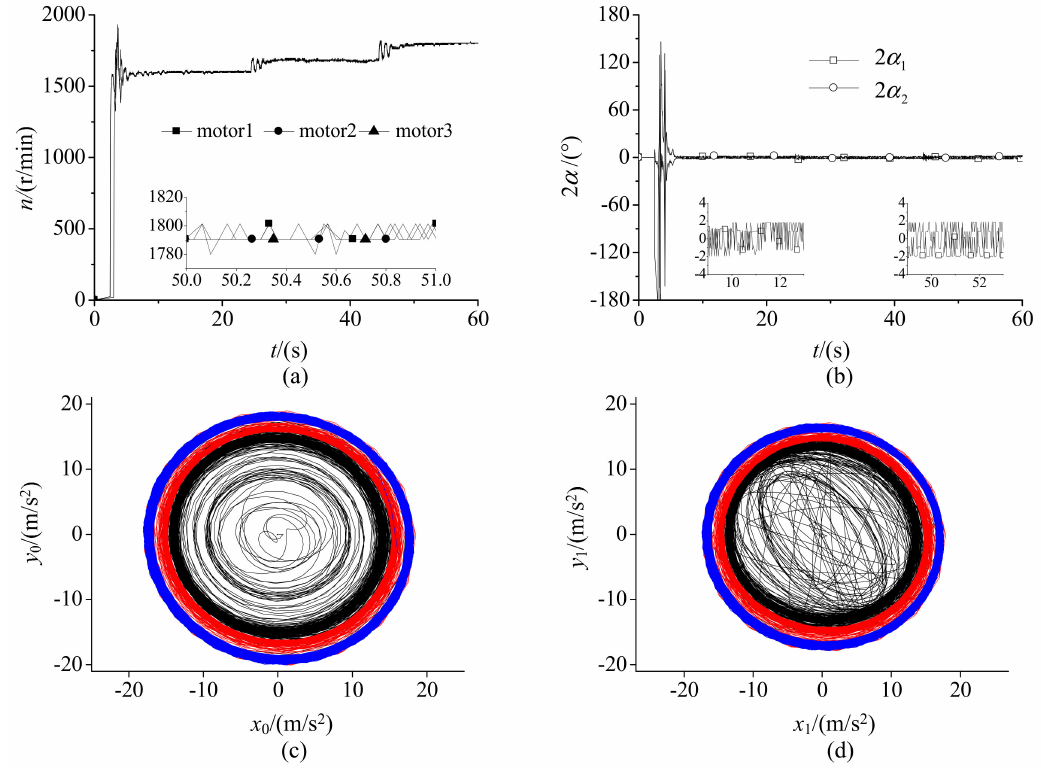
Figure 16. Comparing with the different velocities of the master motor: ( a ) the velocities of three motors; ( b ) the phase differences; ( c ) Mass center trajectory; ( d ) Edge position